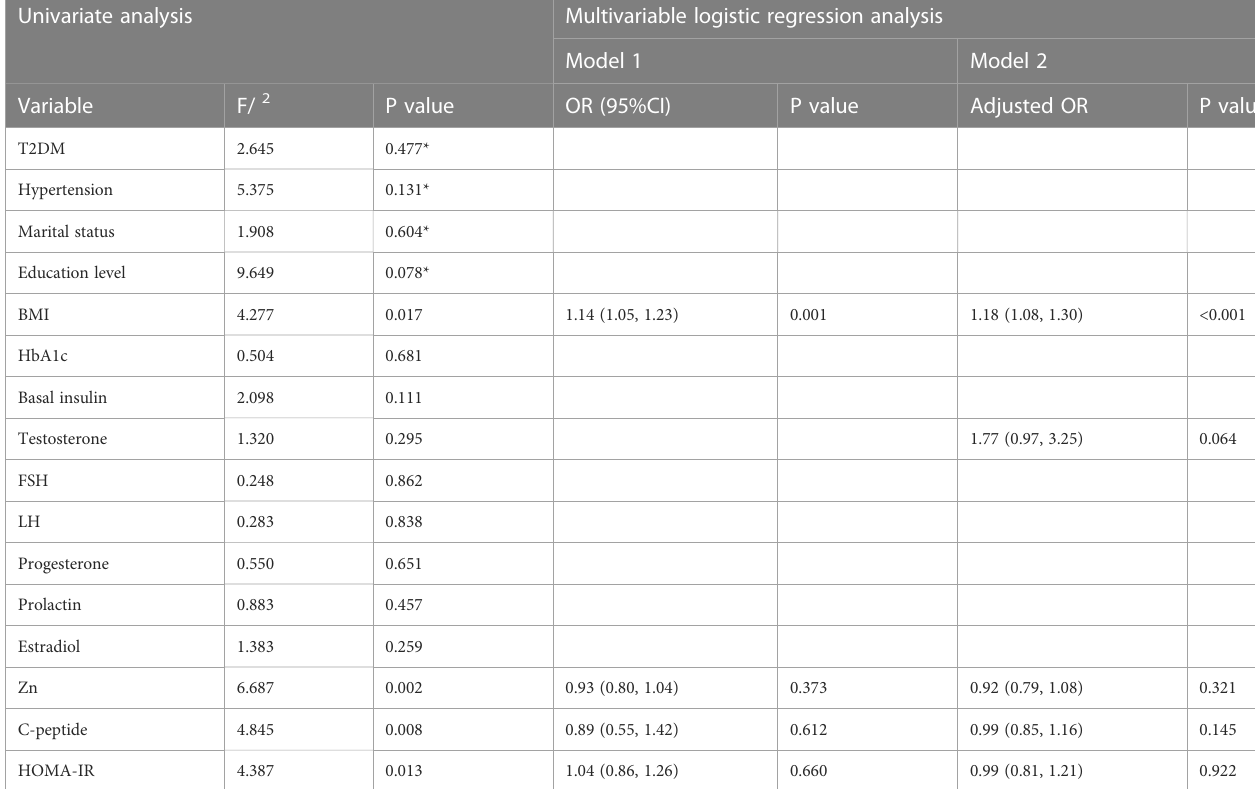
TABLE 2 Univariate and multivariate analyses of risk factors related to preoperative ED grade. Univariate